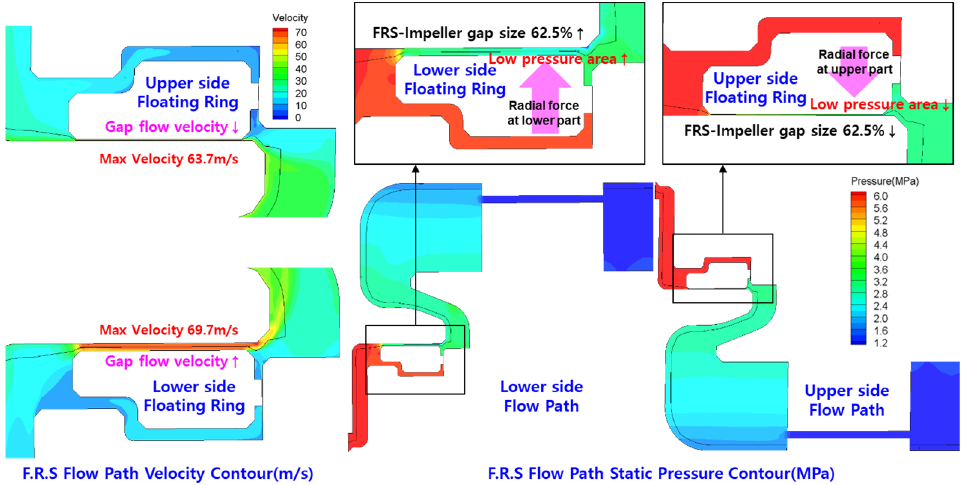
Figure 14. Velocity (m/s) and static pressure (MPa) distributions without difference in gap size of floating ring.